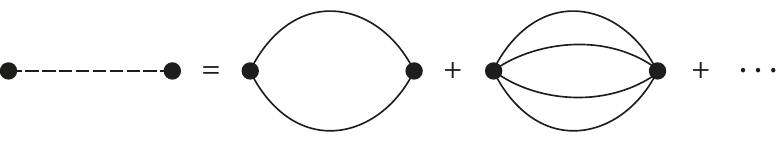
Figure 18 . Graphical representation of the effective bulk-to-bulk propagator as an infinite sum of sets of 2 n propagators of dimension